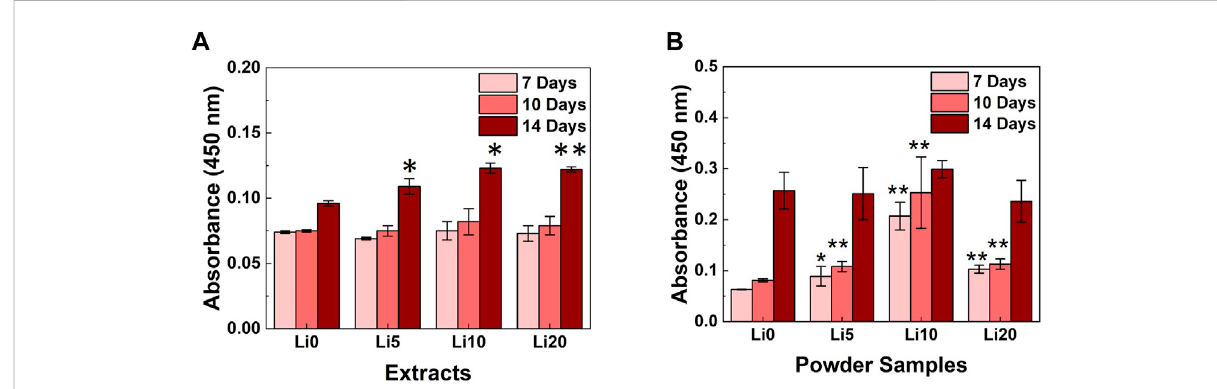
FIGURE 10 ARSactivityresultsforthedifferentculturetimes; (A) 1 mg/wellpowdersamplesand (B) 0.1 g/mlextractedsamples.Asterisksindicatestatistical signi fi cance (* p < 0.05, ** p < 0.01) with respect to Li 0 at the same time point as determined by independent t -test.